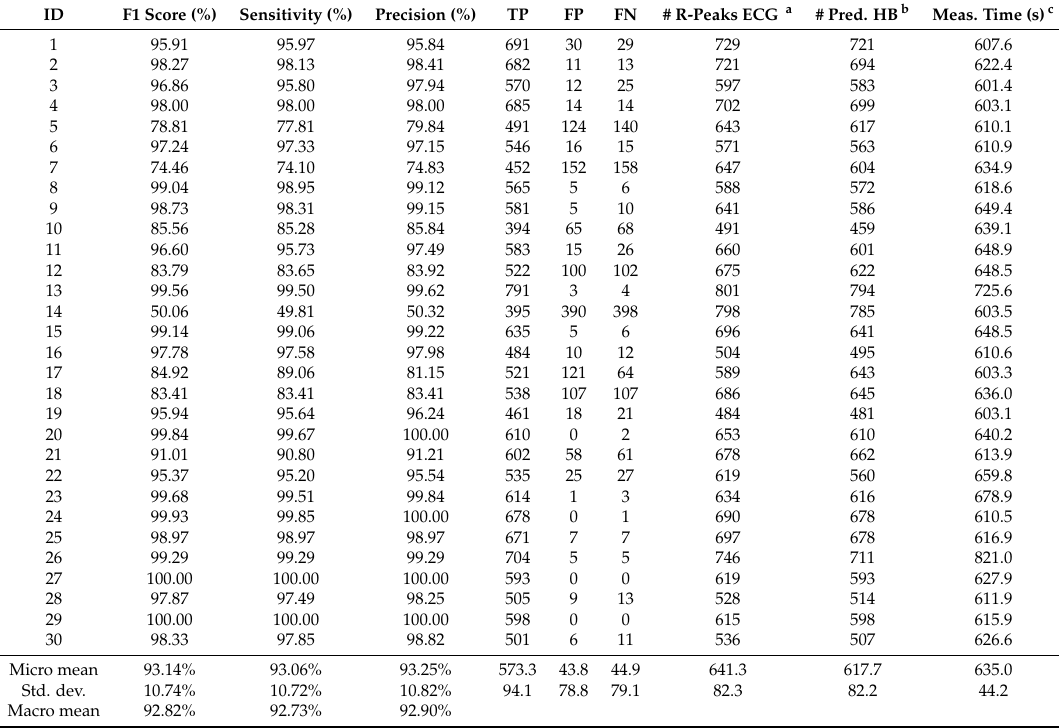
Table 2. Final scores for the heartbeat analysis. The micro mean stands for the direct mean overall test subjects, whereas the macro mean is calculated from the sum of all true positive (TP), false positive (FP) and false negative (FN) values.